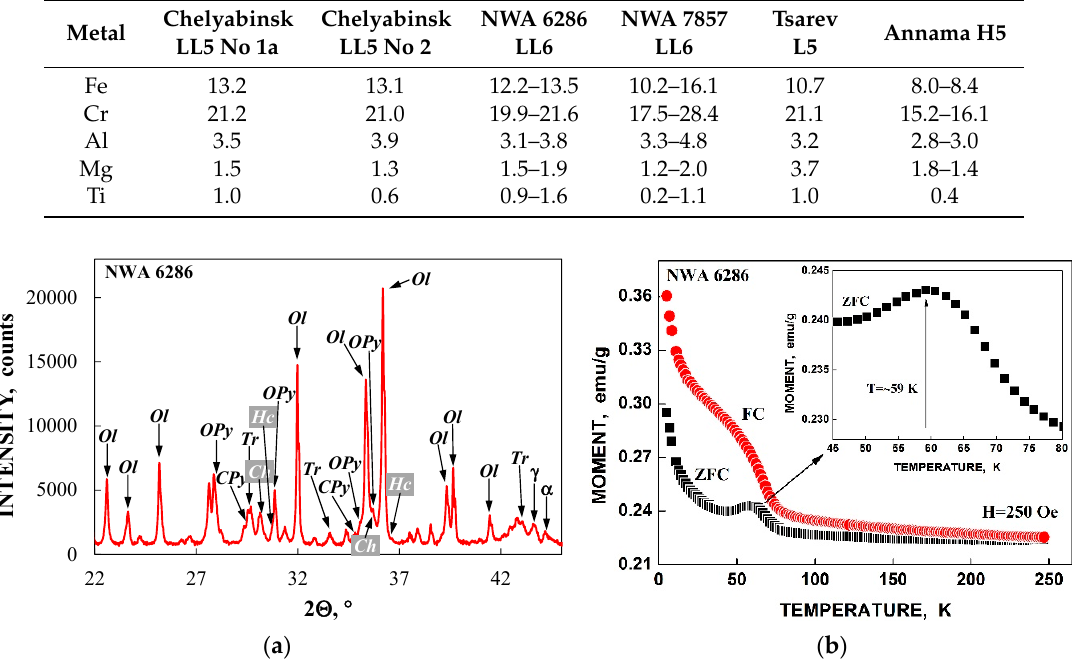
Table 1. Average values and ranges of the content (in at. %) of some metals determined in selected chromite inclusions in ordinary chondrites by energy dispersive spectroscopy.